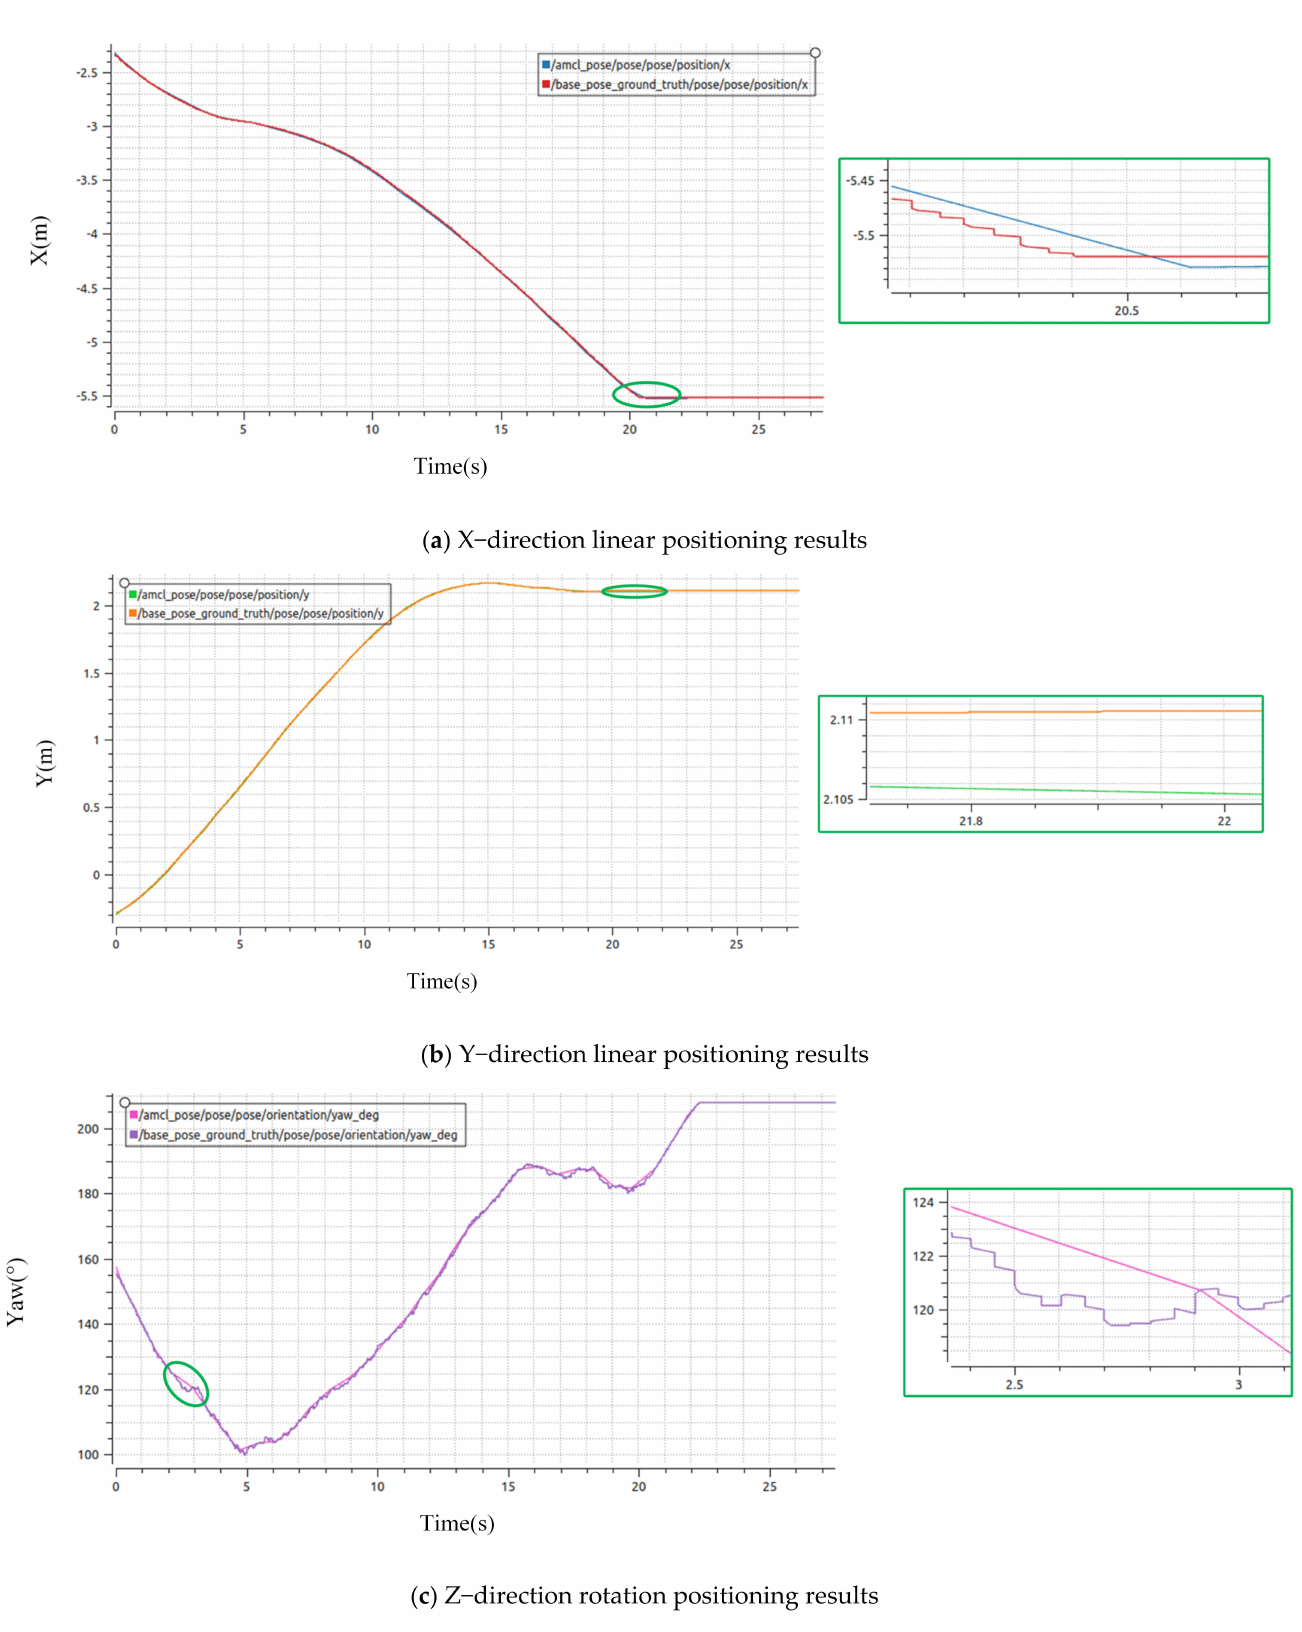
Figure 9. Results of the first group of improved AMCL simulation positioning